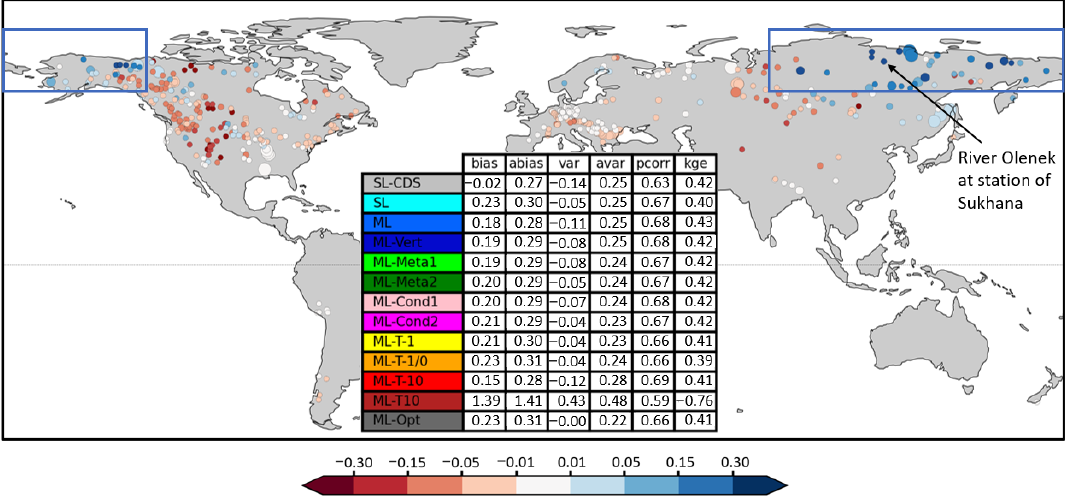
Figure 7. Difference of the modified Kling – Gupta efficiency ( kge ) between ML-Opt and ML. Blue areas show better performance in ML-Opt, while red indicates better performance in ML. The sensitivity area in the permafrost is shown by blue rectangles, while the test catchment on river Olenek at station Sukhana is indicated by black arrow. The area average scores are provided for all analyzed experiments in the inset table.